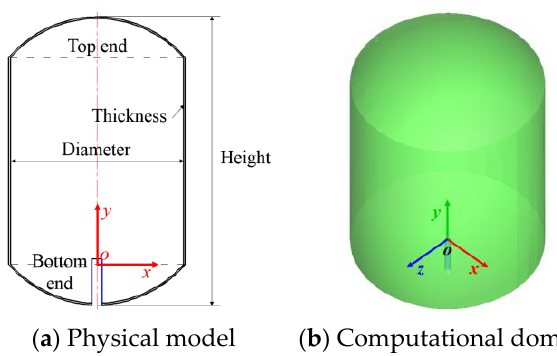
Figure 1. Schematic of the liquid hydrogen storage tank. ( a ) Physical model of the liquid hydrogen storage tank; ( b ) Computational domain of the liquid hydrogen storage tank.